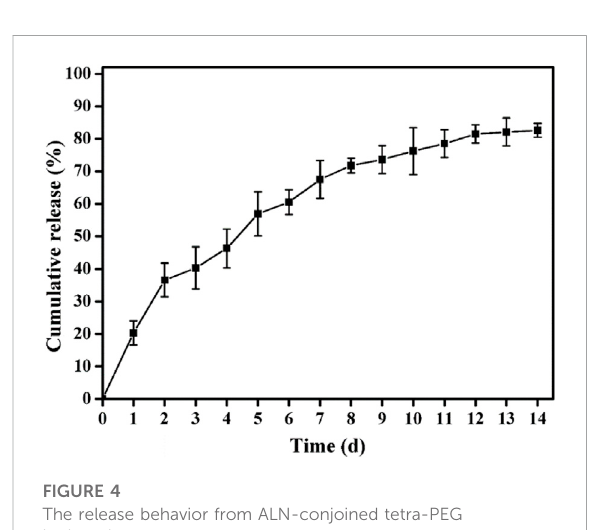
FIGURE 4 The release behavior from ALN-conjoined tetra-PEG